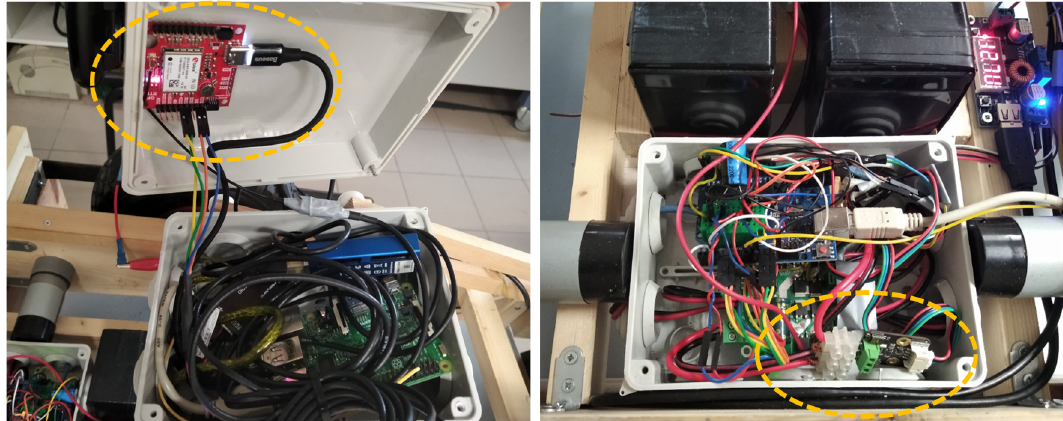
Figure 11. The hardware arrangements of the robotic vehicle providing RTK-level accuracy (in the left ) and efficient energy measurement (in the right ). The key components (i.e., the RTK GPS and the INA219 power meter) are enclosed inside dashed circles.